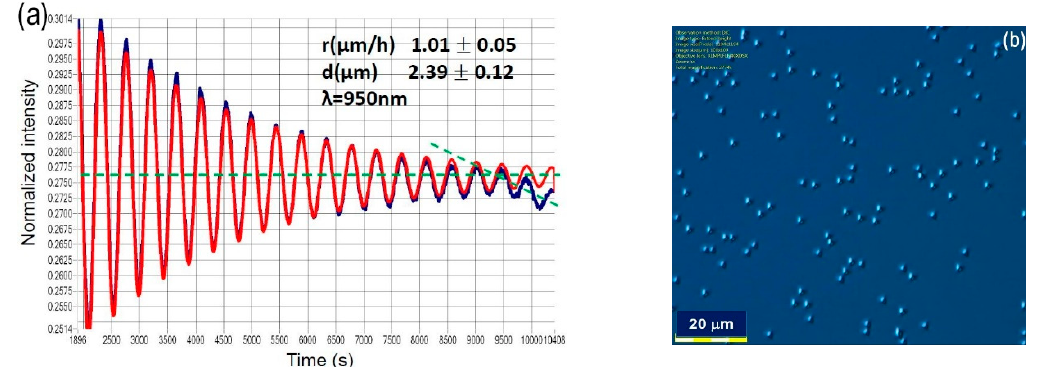
Figure 1. ( a ) comparison of normalized intensity of optical reflection at wavelength 950 nm from the surface of In 0.52 Al 0.48 As sample measured during MBE growth for microdefects-free growth (red line) and for growth with the onset of microdefects and related roughening of sample’s surface in microscale (blue line). Reflectivity was recorded for growth of a 2.5 µ m thick In 0.52 Al 0.48 As layer of the upper waveguide on top of the QCL active region. The growth rate was ~1 µ m / h; ( b ) Nomarski microscopy picture of surface of 2.5 µ m thick In 0.52 Al 0.48 As layer for sample with microdefects developed during MBE growth.